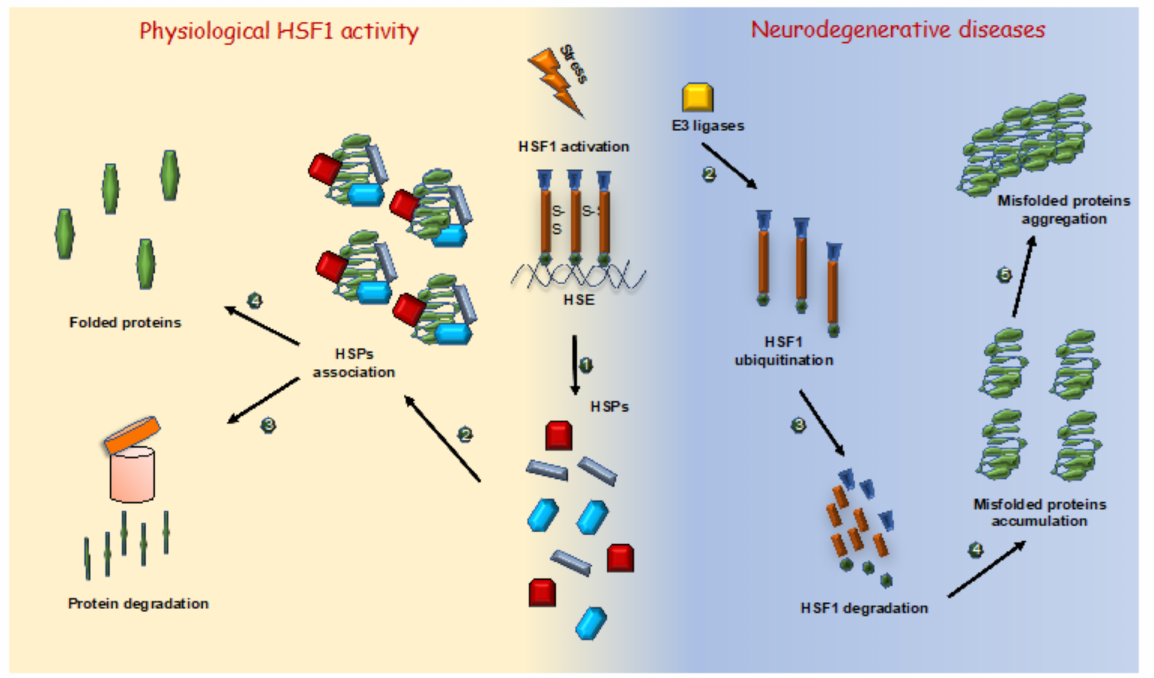
Figure 3. HSF1 action in physiological condition and in neurodegenerative diseases. Left panel. During a period of proteotoxic stress, HSF1 trimers bind HSE sequences promoting HSPs expression (1). Misfolded proteins are bound by HSPs (2) driving them toward proteasomal degradation (3) or facilitating their folding (4). Right panel . In neurodegenerative diseases several E3 ligases interact with HSF1 (2) promoting its ubiquitination and degradation (3). The reduction in HSPs expression leads to an accumulation of misfolded proteins (4) turning out in the formation of toxic aggregate